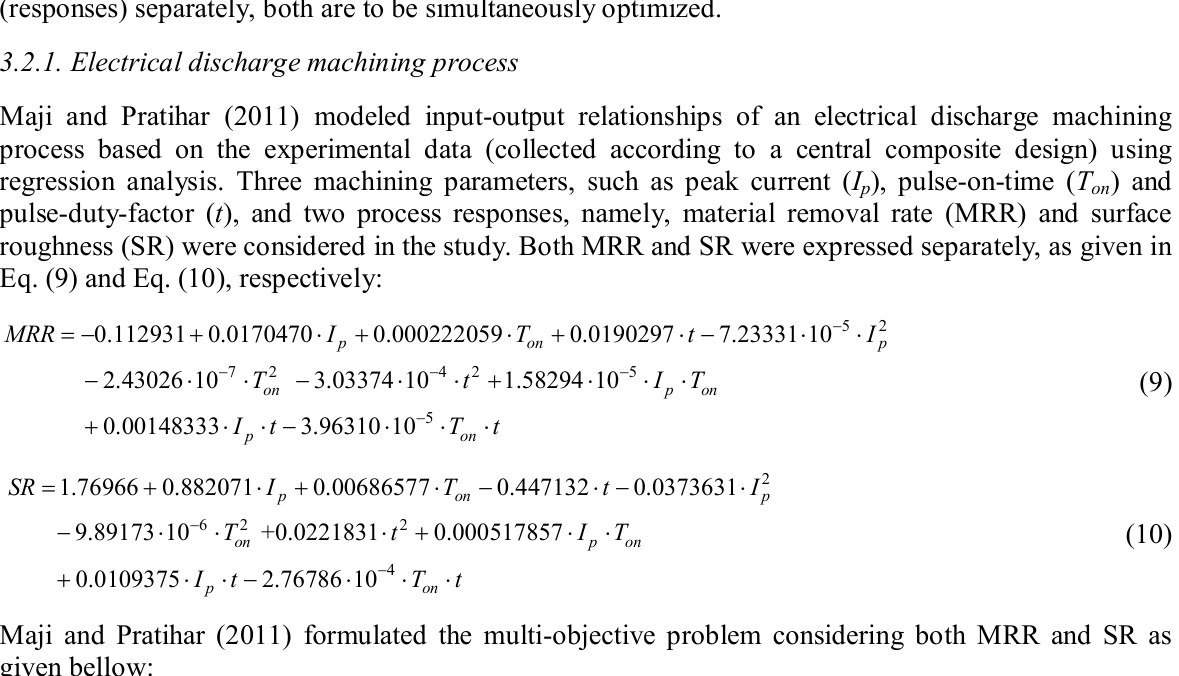
Comparison of optimization solutions for electrical discharge machining process Approach